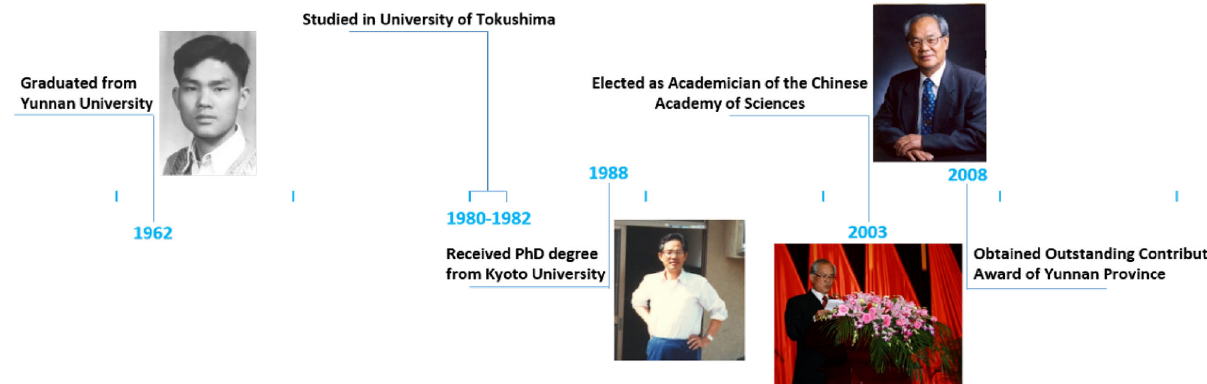
Fig. 1 Milestones of Prof. Han-Dong Sun Fig. 2 Representative chemical constitutes of natural